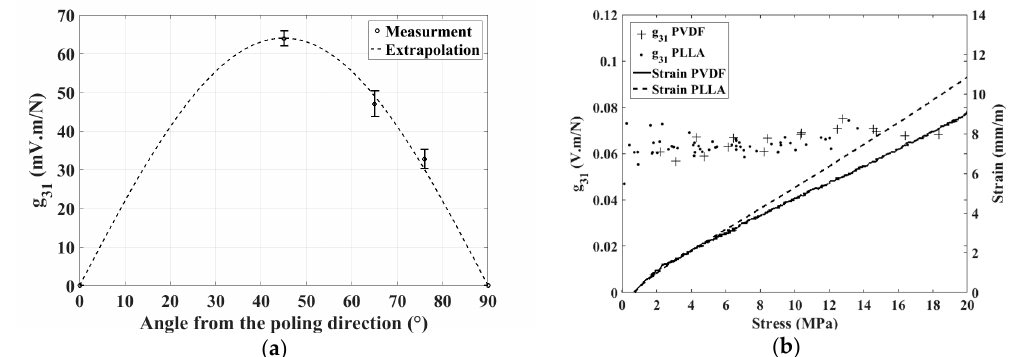
Figure 3. ( a ) Influence of the angular direction on the piezoelectric coefficient g 31 of the PLLA from the stretching direction; ( b ) Dependences of the direct piezoelectric voltage coefficient g 31 and strain- stress curve for PVDF and PLLA (at 45° from the stretching